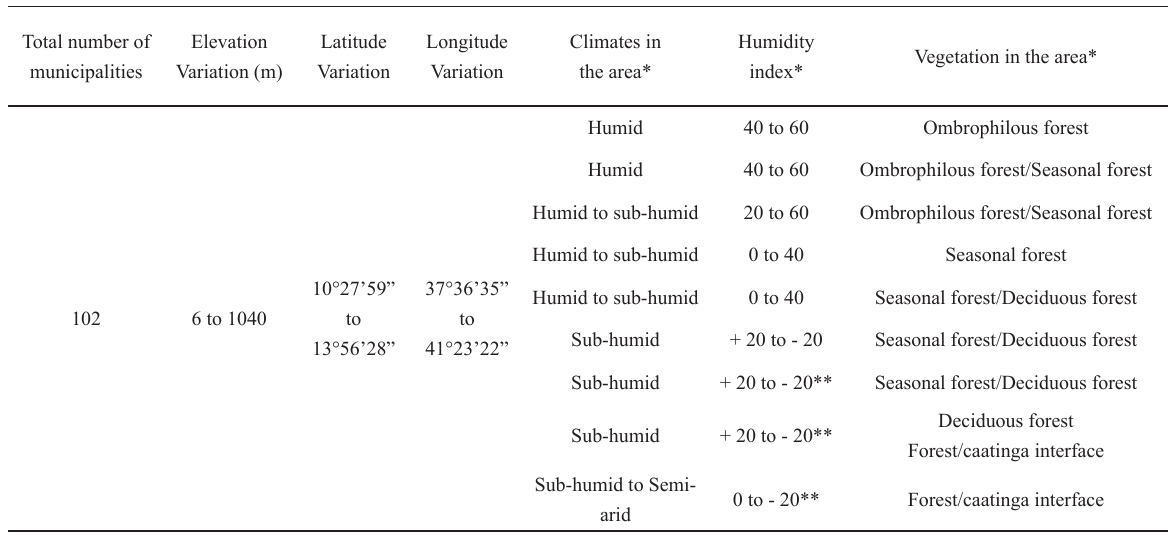
Natural occurrence of Melipona scutellaris in the state of